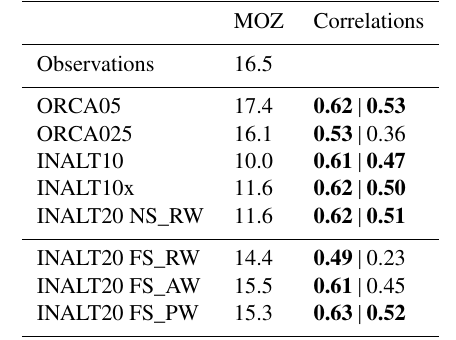
Table 7. Mean (2000–2009) transport (in Sv) of the Malvinas Cur- rent (MC) at 41 ◦ S and the North Brazil Current (NBC) at 11 ◦ S. Observational values are from Artana et al. (2018) and Hummels et al. (2015),